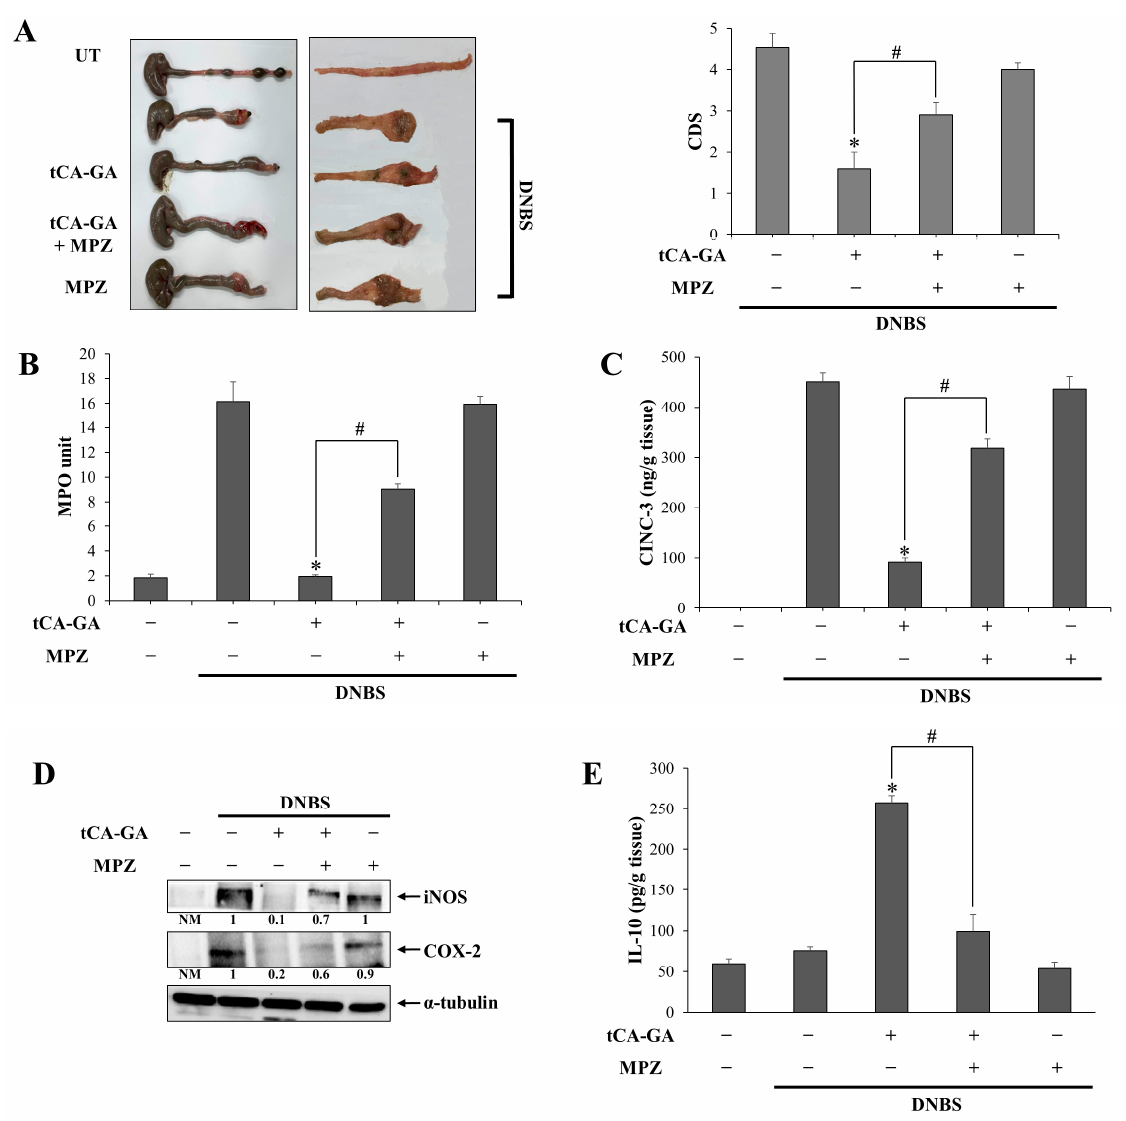
Figure 5. Anti-colitic effects of tCA-GA are blunted by a GPR109A antagonist. DNBS-mediated colitis was induced for 3 days, and tCA-GA (28 mg/kg), tCA-GA (28 mg/kg) + MPZ (2 mg/kg), or MPZ (2 mg/kg) suspended in PBS (1.0 mL) were administered orally to colitic rats once per day. Additionally, one day after sixth treatment with each drug, the rats were killed to evaluate anti-colitic effects of the drugs. ( A ) Left panel: Photos of the distal colons of rats where serosal and luminal sides are shown separately. Right panel: Overall colonic damage was scored for each group and presented as colonic damage score (CDS). * α < 0.05, vs. DNBS control. In the inflamed distal colons (4.0 cm), ( B ) myeloperoxidase (MPO) activity was measured in addition to determining the levels of ( C ) CINC-3, ( D ) iNOS and COX-2, as well as ( E ) IL-10 using ELISA kits and Western